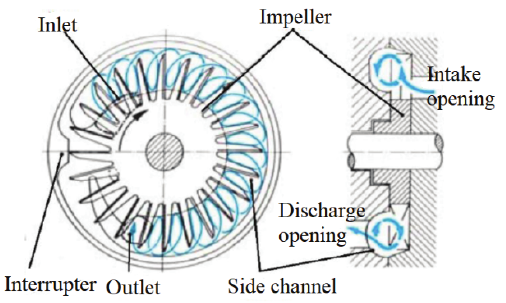
Figure 1. Fluid pathways in side channel pump.